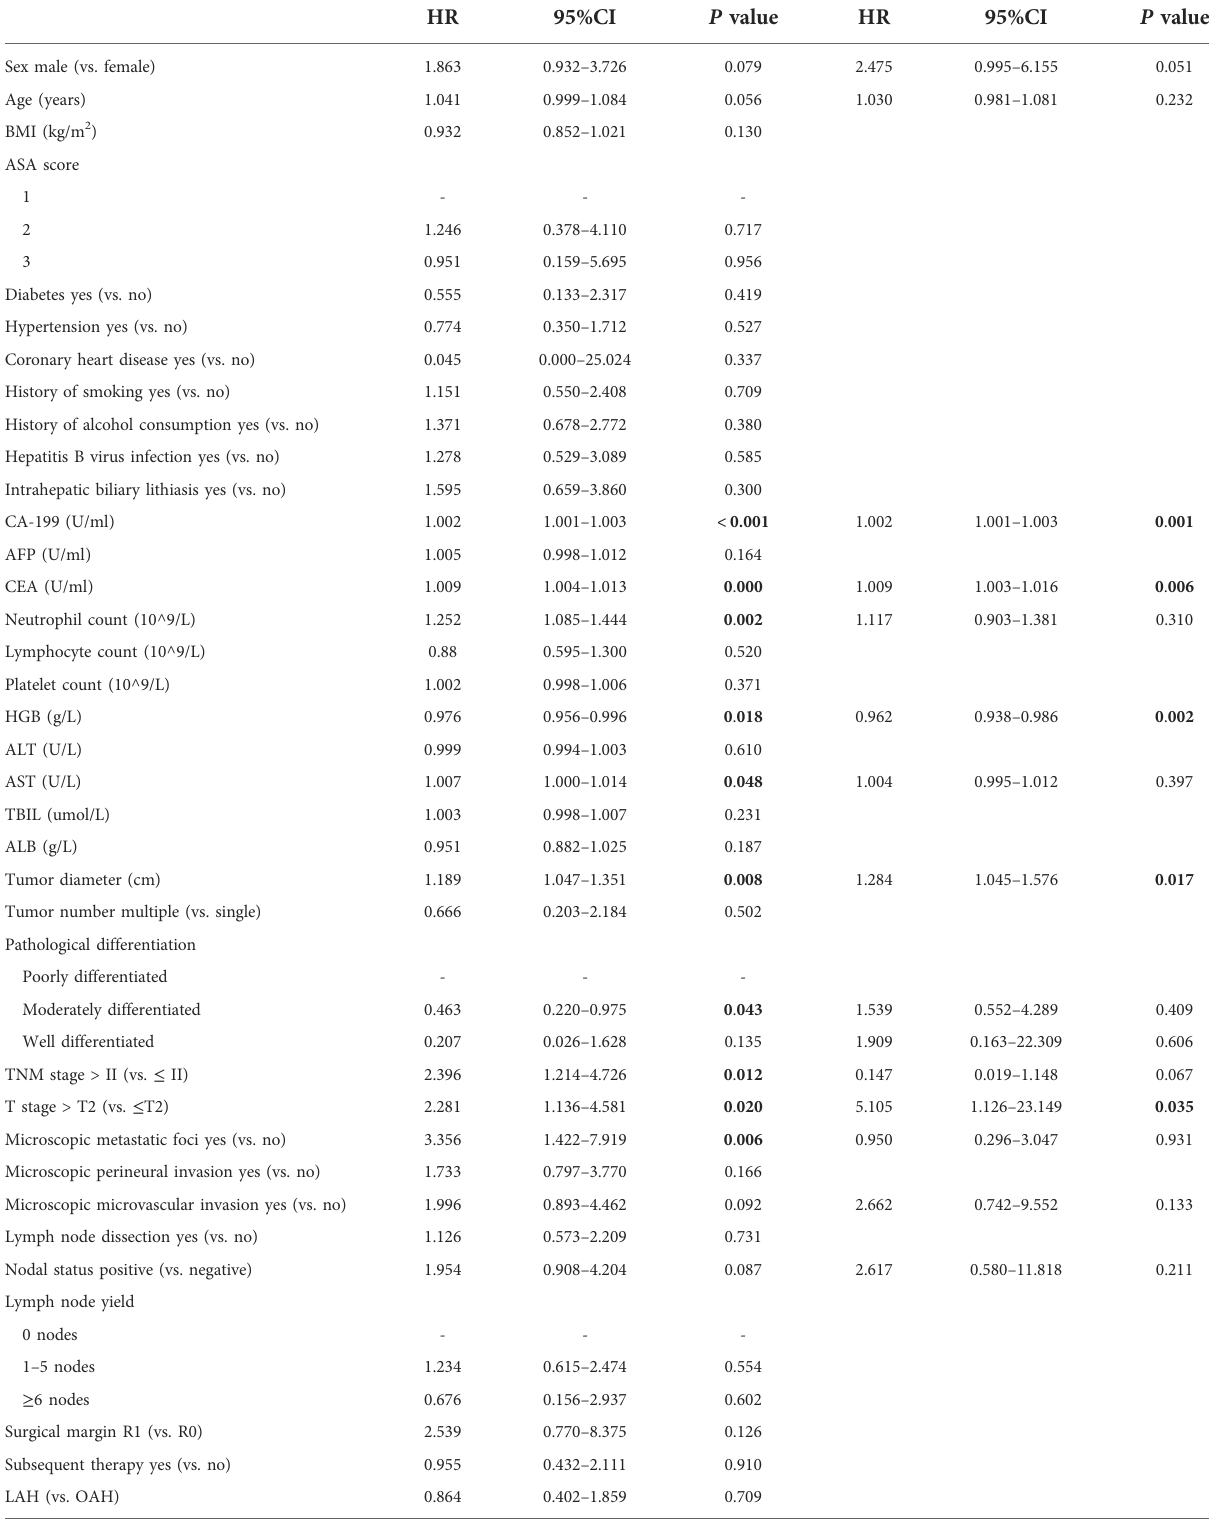
TABLE 4 Univariate and multivariate analyses of factors associated with overall survival